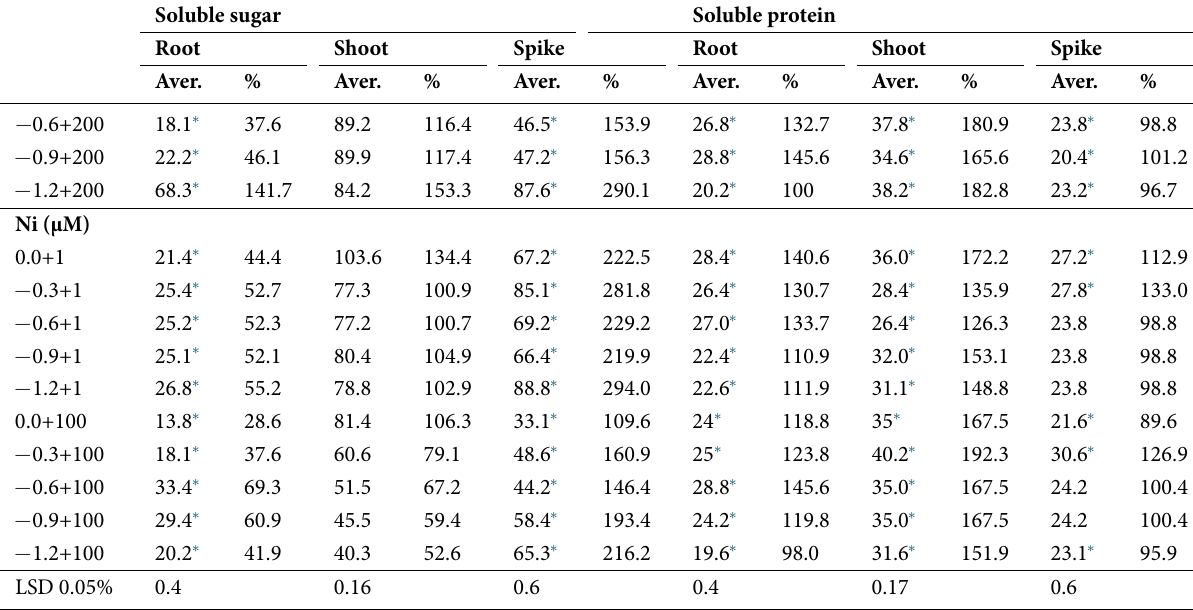
Table 3 Amino acids (mg/g dry matter) and proline (mg/g dry matter) content in roots, shoots and spikes of wheat treated by different osmotic stress levels with or without Zn (20 and 200 μM) or Ni (1 and 100 μM) supplementation. Amino acids